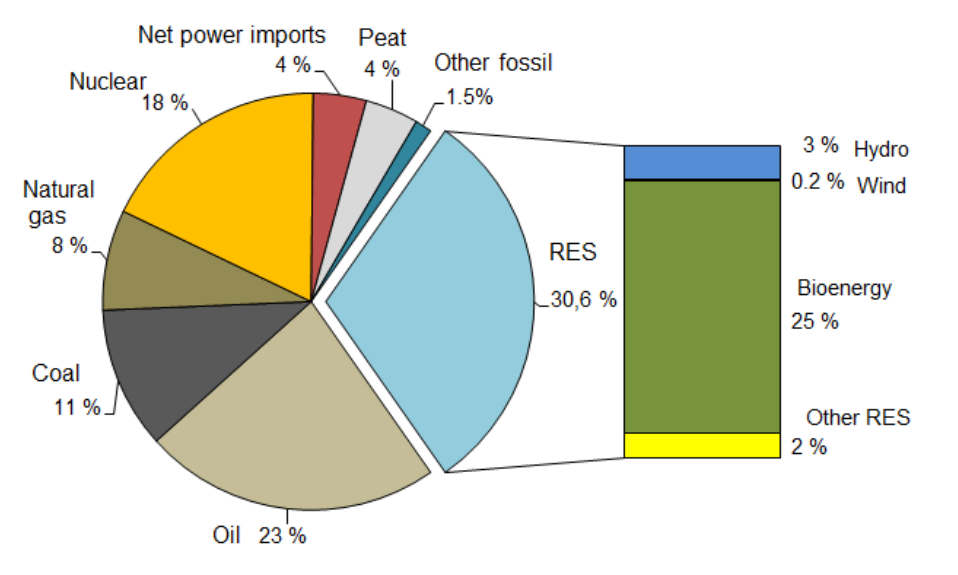
Figure 3. Total PEC (primary energy consumption) in Finland 2013 (data from